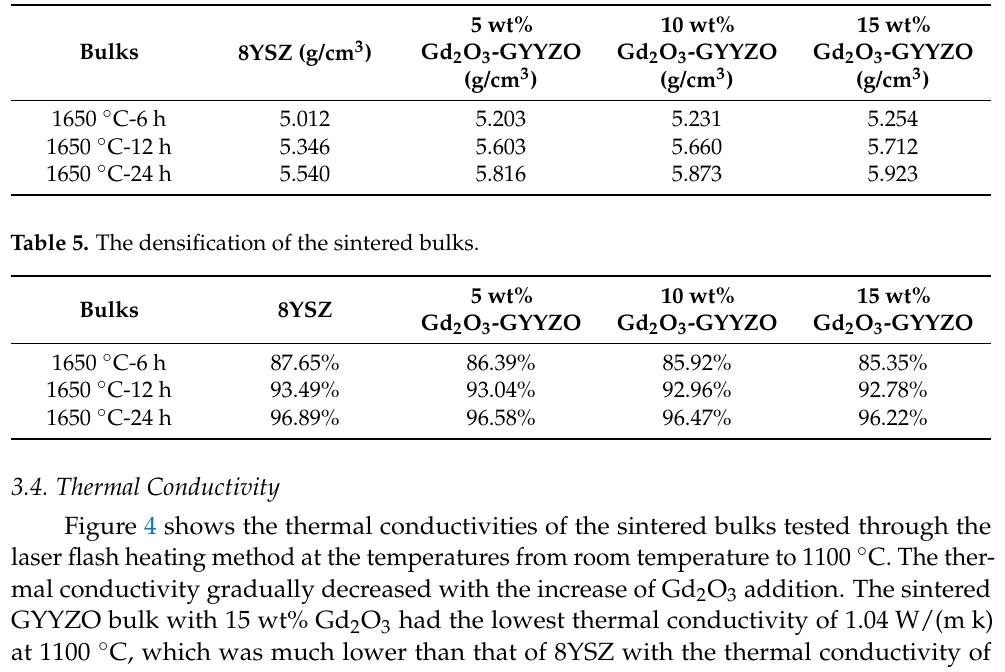
Table 4. The densities of the sintered 8YSZ and GYYZO bulks.